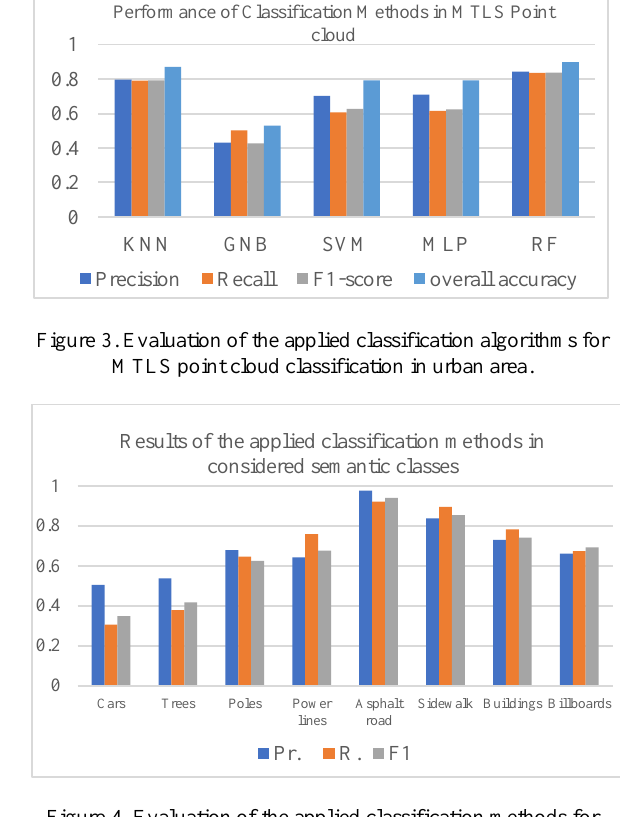
Figure 4. Evaluation of the applied classification methods for considered semantic